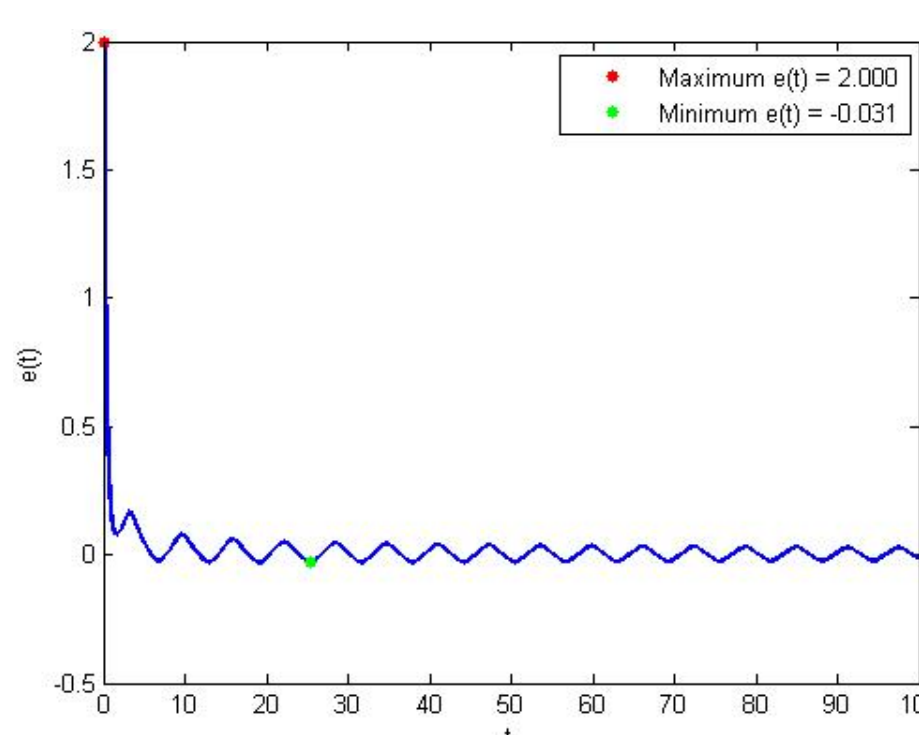
−𝑡 ] 𝑇 . 2 (cid:105) T (cid:104) 1 e − t . −𝑡 2 ] 𝑇 . 2